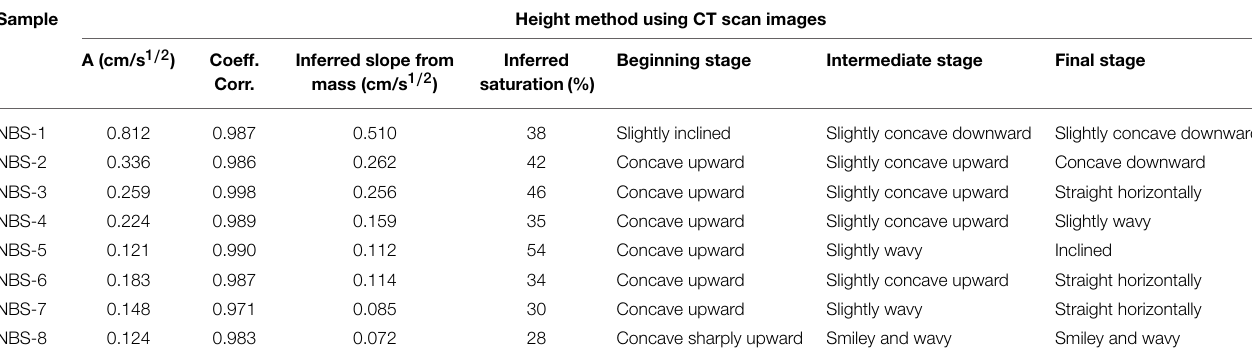
TABLE 2 | Capillary parameter A of the Nubia sandstone samples obtained with the height method using CT scan images, and qualitative description of the capillary front geometry. Sample Height method using CT scan images A (cm/s 1 / 2 ) Coeff.